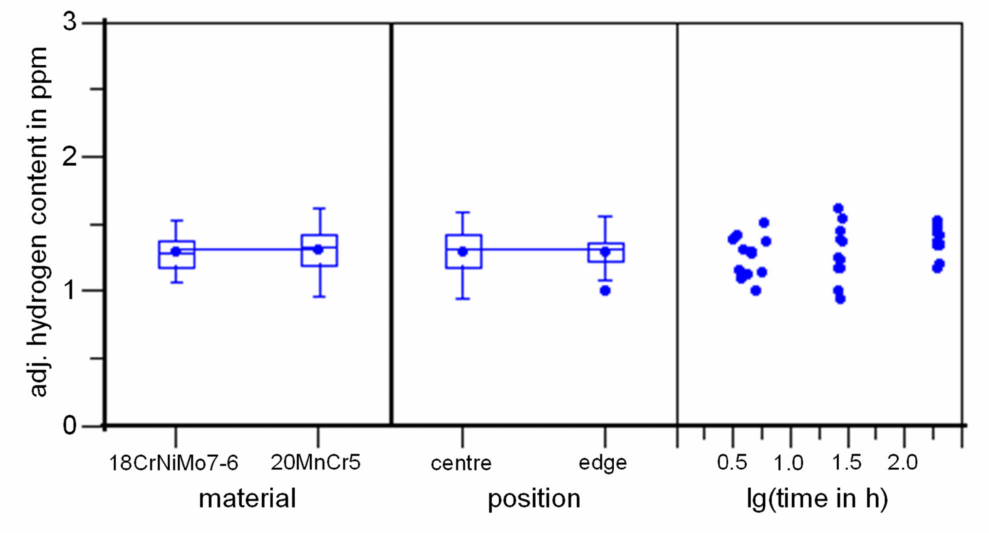
Figure 11. Effects of the factors material, position and logarithmic storage time on the total hydrogen content of the samples tempered at 180 ◦ C/1 h (adj. R 2 = 0.05, F =